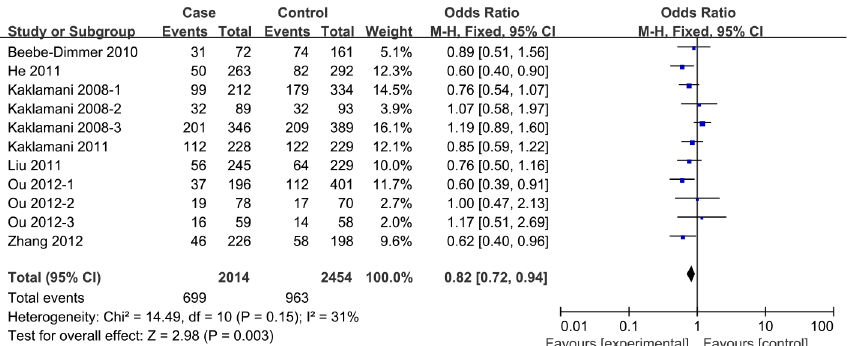
Fig 3. Forest plot of the association between ADIPOR1 SNP rs1342387(G/A) and cancer risk in a homozygous